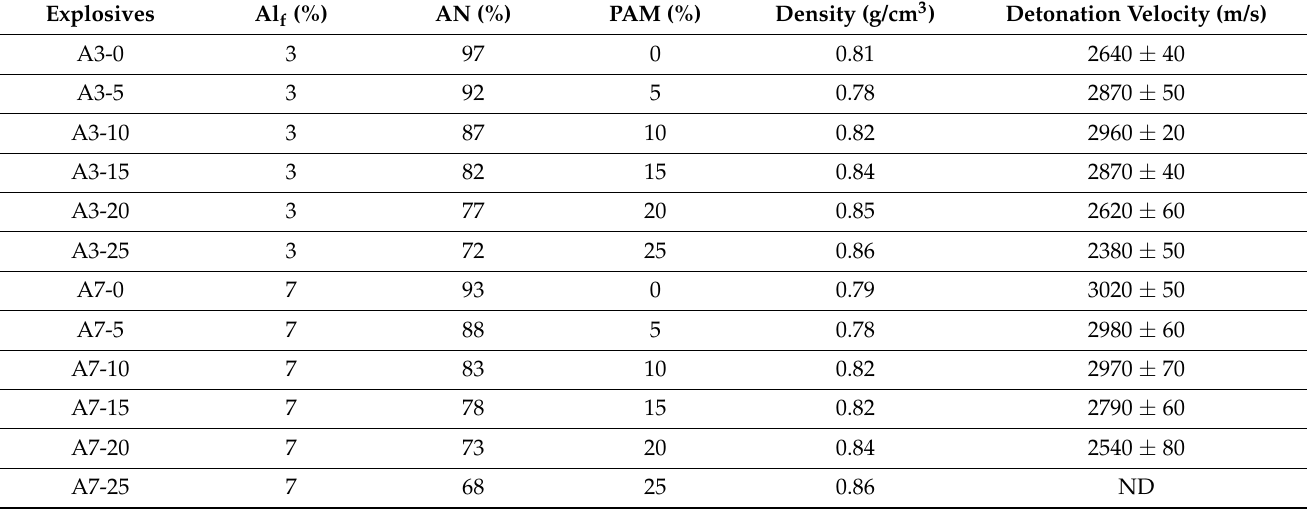
Table 1. Names and compositions of the tested explosives and detonation velocity